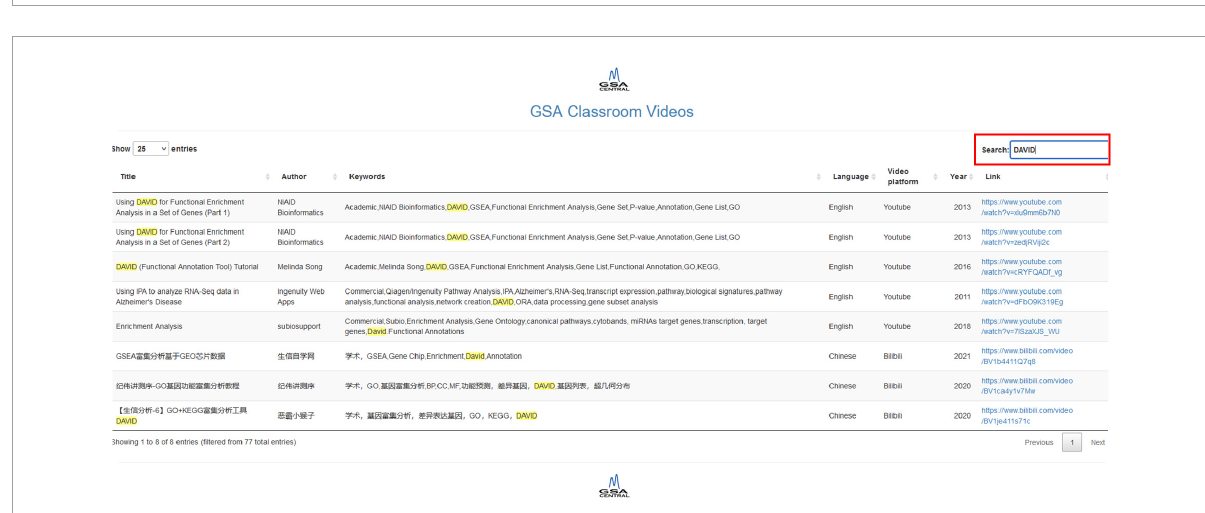
FIGURE3 GSA Classroom screenshot. In this example, we searched for the keyword “DAVID” and found all online videos where it appears either in the title or in the keyword